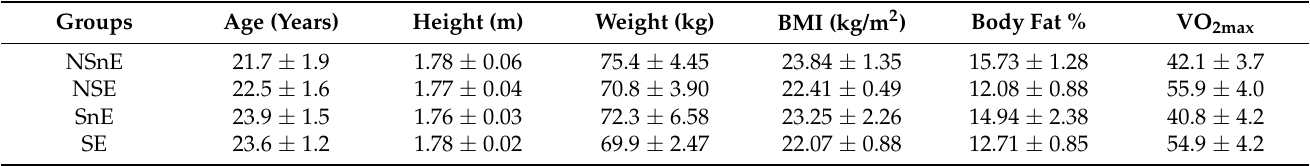
Table 1. Characteristics of individuals in